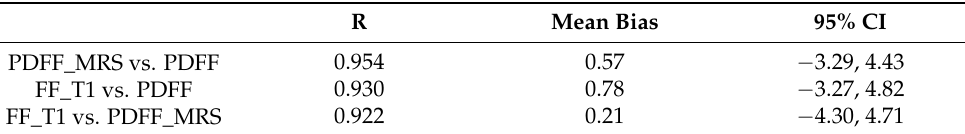
Table 2. Pearson correlation coefficient R and Bland–Altman analysis for liver fat measurements